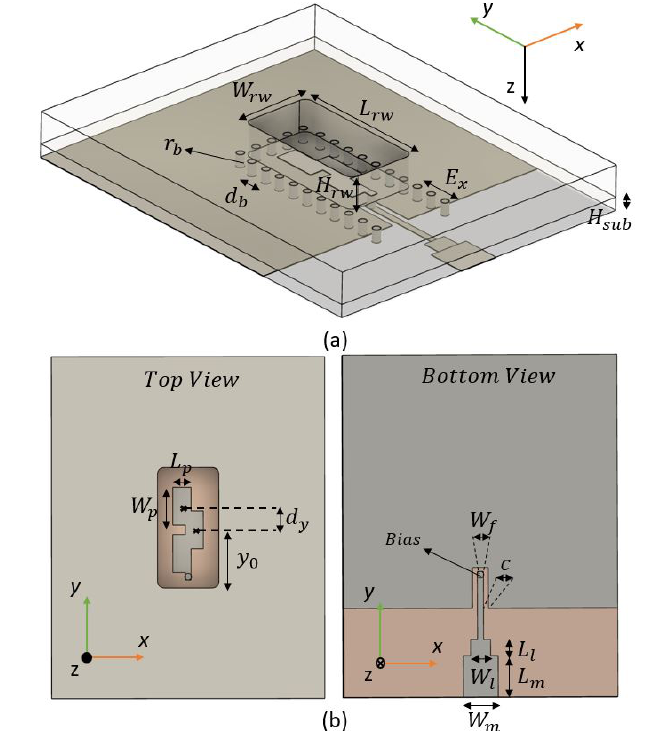
Figure 4. Artist view of the Bottom-Side transition for ( a ) isometric view and ( b ) top and bottom